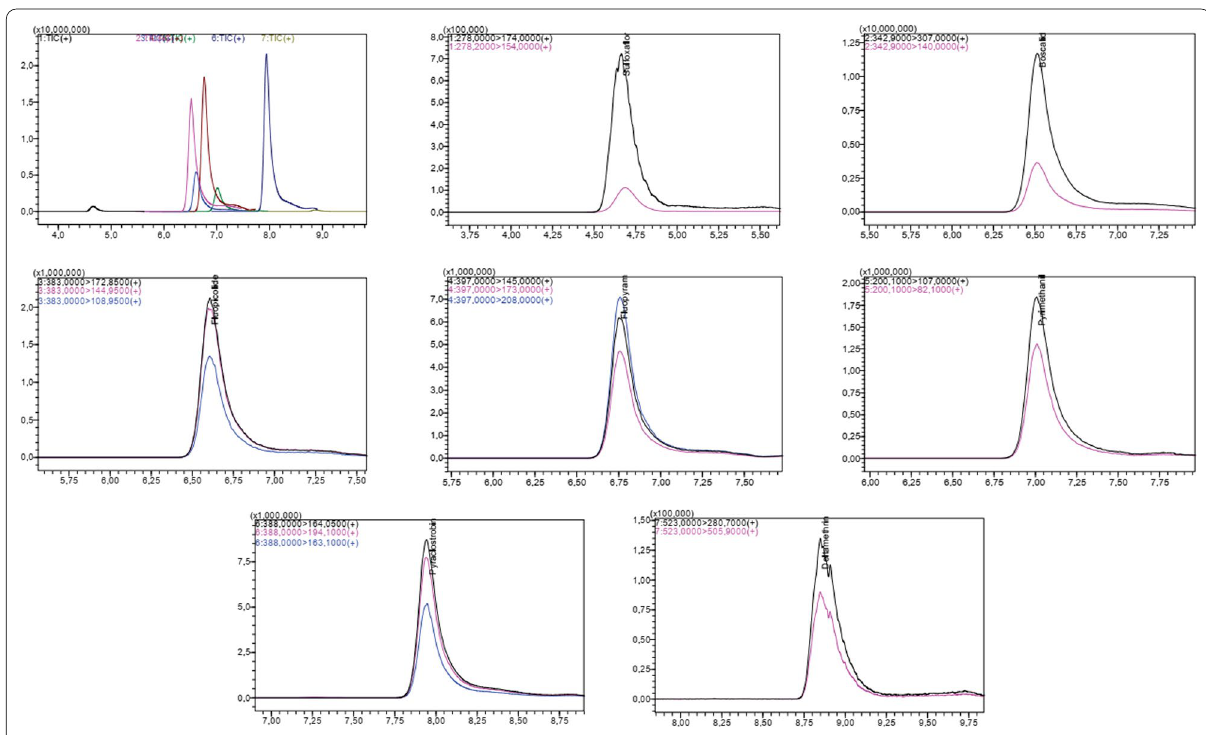
Fig. 2 Total ion chromatogram (TIC) and selected ion mass chromatograms for 7